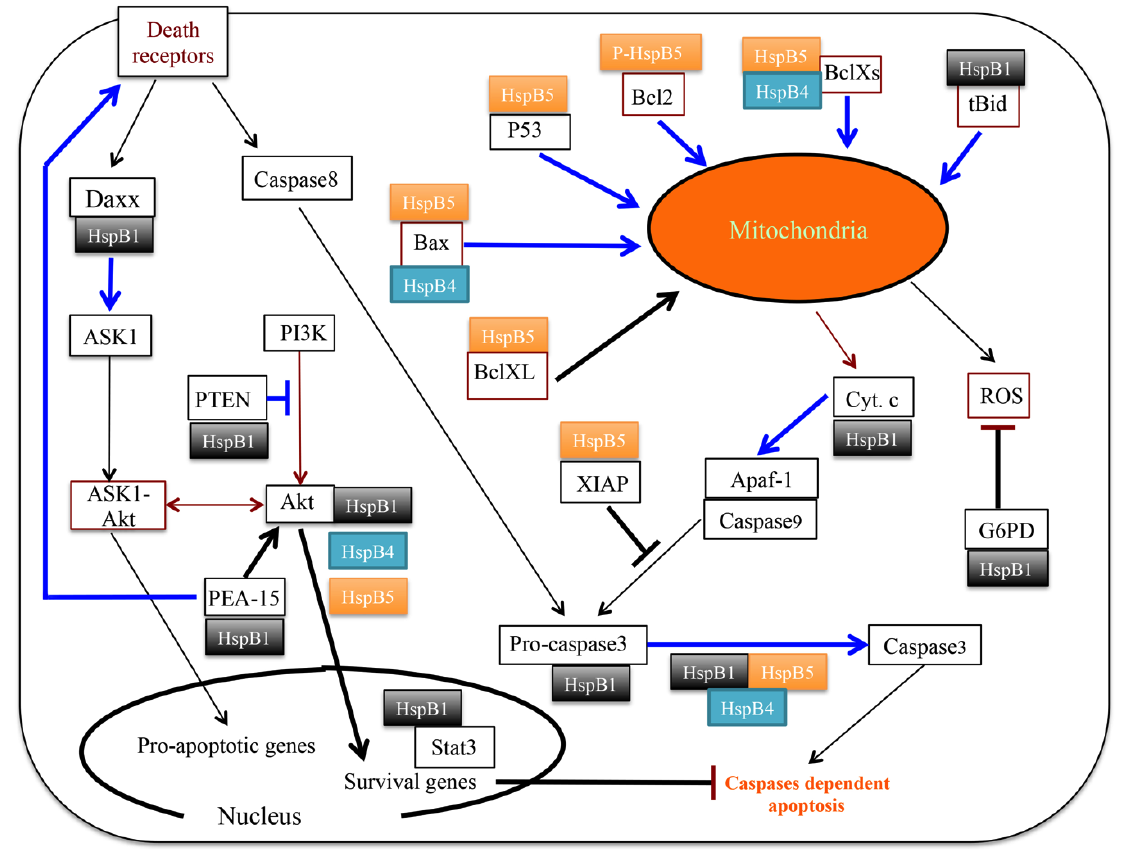
Figure 2. Cartoon that summarizes the apoptotic and survival pathways controlled by HspB1, HspB5 and HspB4. Large blue arrows are indicative of an inhibition of the corresponding pathways consequently of the binding of the clients to HspB1, HspB5 or HspB4. Black arrows or lines indicate that small Hsps either favorize the indicated pathways or just override